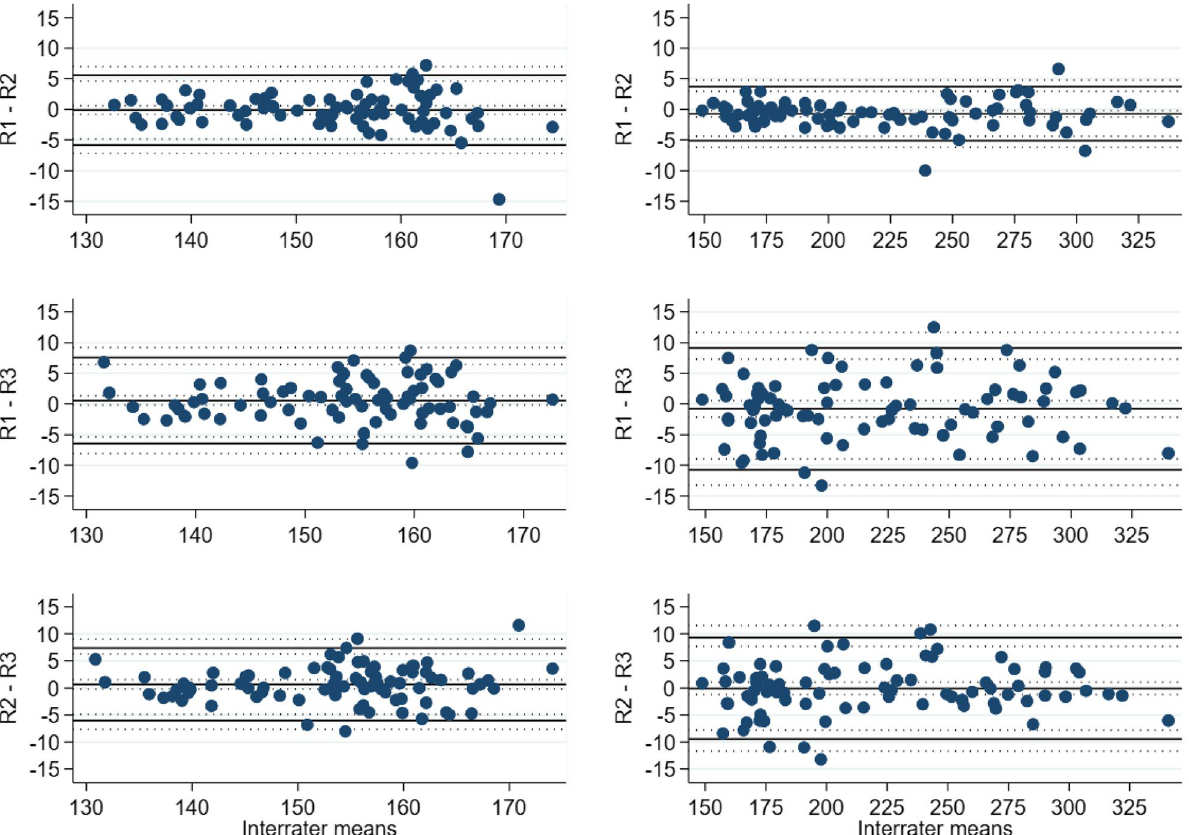
Figure 4. BA LoA plots showing the interrater agreement analysis for µCT-scans [mm 3 ]. Left panel: control. Right panel: lymphedema. BA LoA Bland–Altman Limits of Agreement, mm millimeters, R1 rater 1, R2 rater 2, R3 rater 3, CT computed tomography, μ